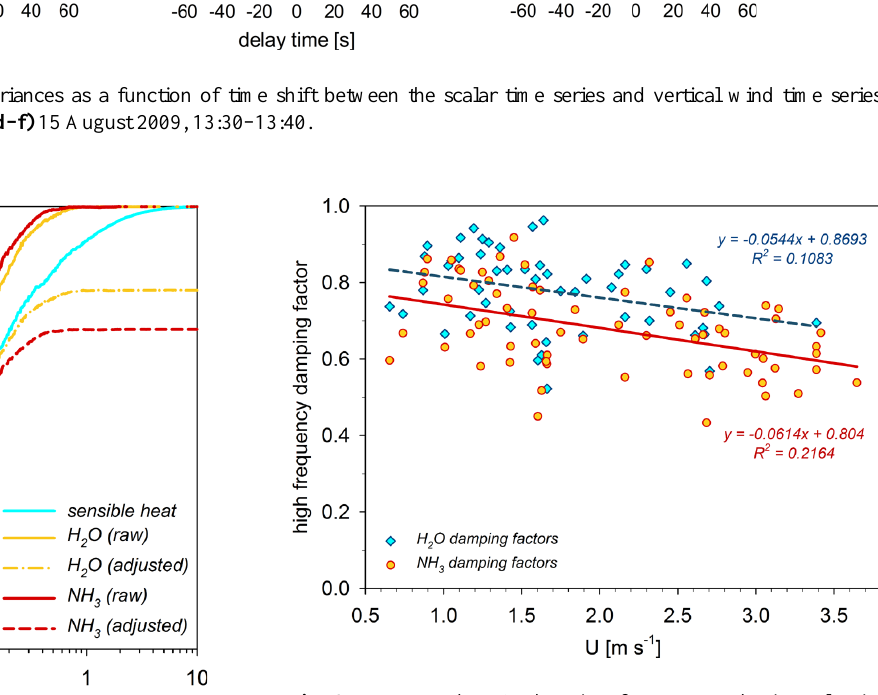
Fig. 8. NH 3 and H 2 O damping factors vs. horizontal wind speed ( U ) on 4 August 2009 and 6 August